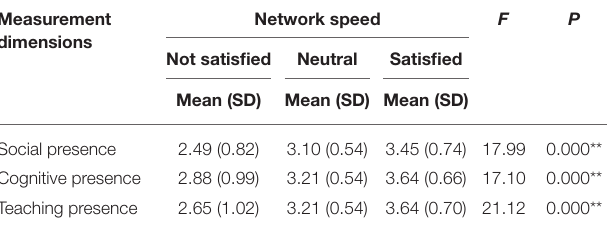
TABLE 7 | The effects of network speed satisfaction toward different CoI measurement dimensions. Measurement